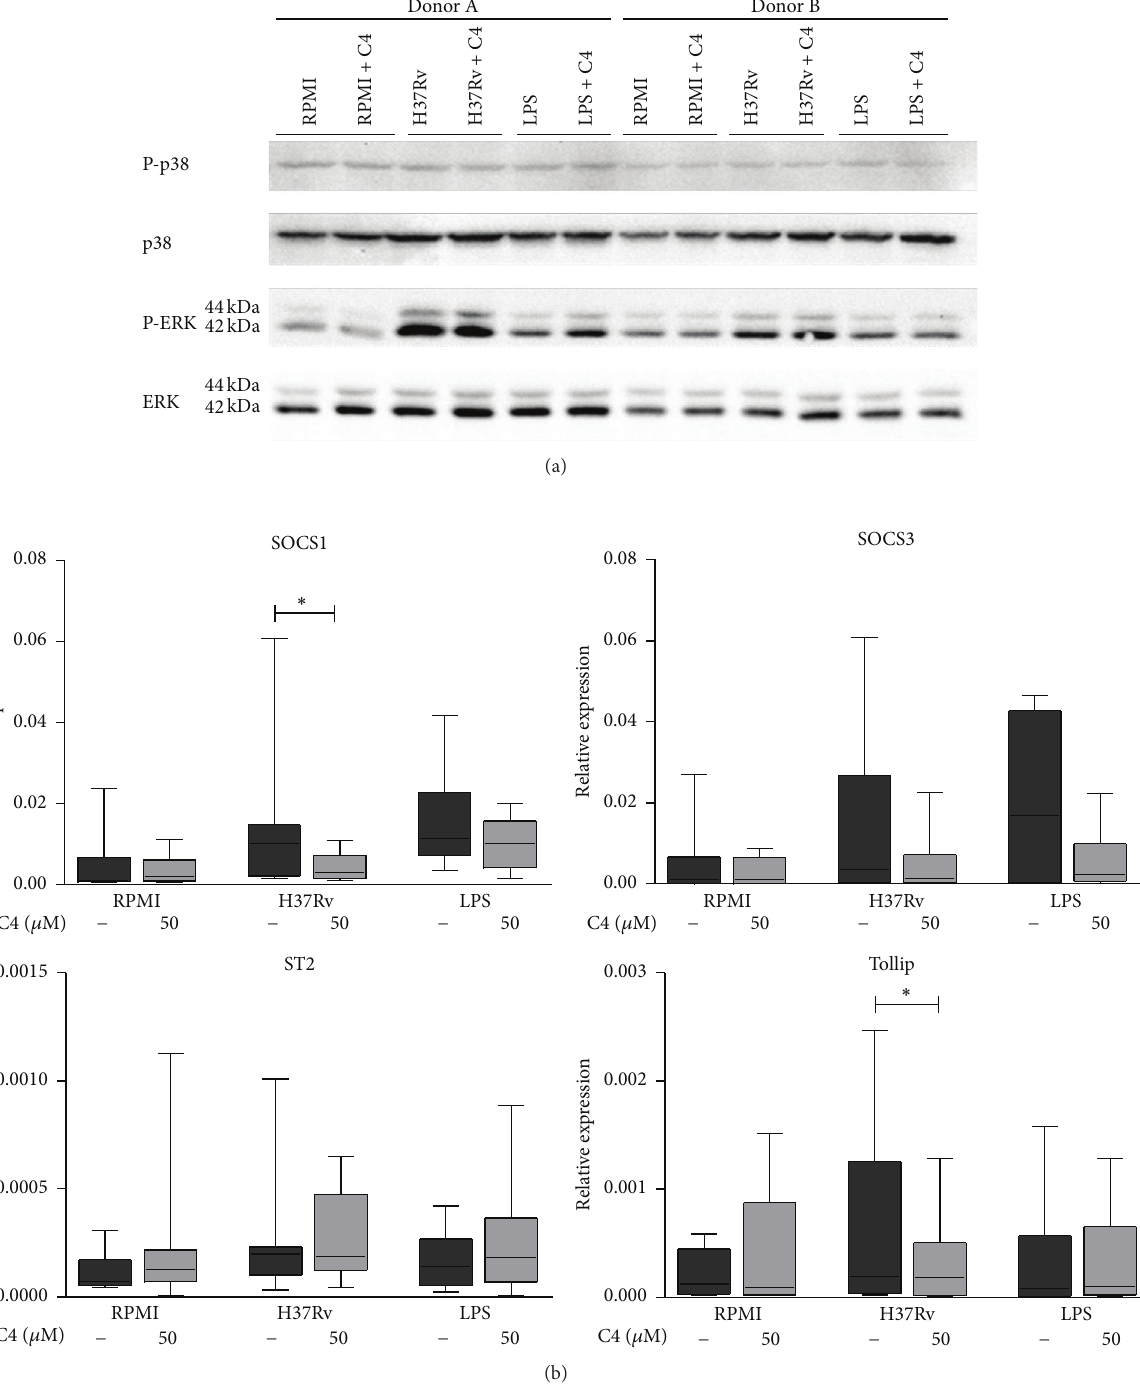
Figure 3: The effects of butyrate on TLR signalling mediators. (a) PBMCs were preincubated with 50 𝜇 M C4 (1h) and stimulated with Mtb lysate or LPS. Cell lysates were harvested at 30 min after stimulation. Phospho-p38, p38, phospho-ERK, and ERK protein levels were determined by Western blot using specific antibodies ( 𝑛 = 2 ). (b) Gene expression levels of SOCS1, SOCS3, ST2, and Tollip in PBMCs preincubated with 50 𝜇 M C4 (1h) and stimulated with Mtb lysate or LPS (4h) as measured by qPCR. The box plot represents median with first and third quartiles; the whiskers represent minimum and maximum values. 𝑛 = 10 , using Wilcoxon signed-rank test, representative of 3 independent experiments. ∗ 𝑝 < 0.05